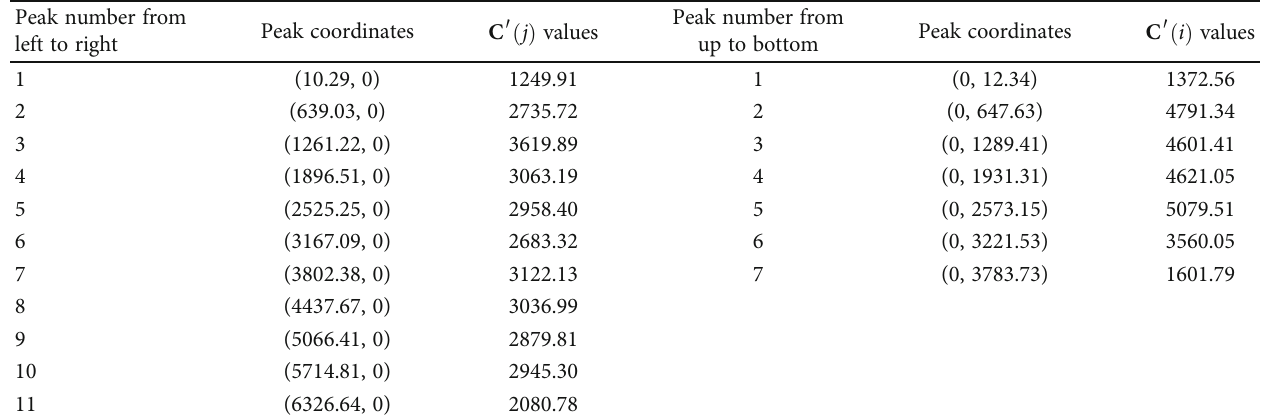
Figure 7: Edge search process of SPQS algorithm. Table 2: Positioning results of silicon wafer edge